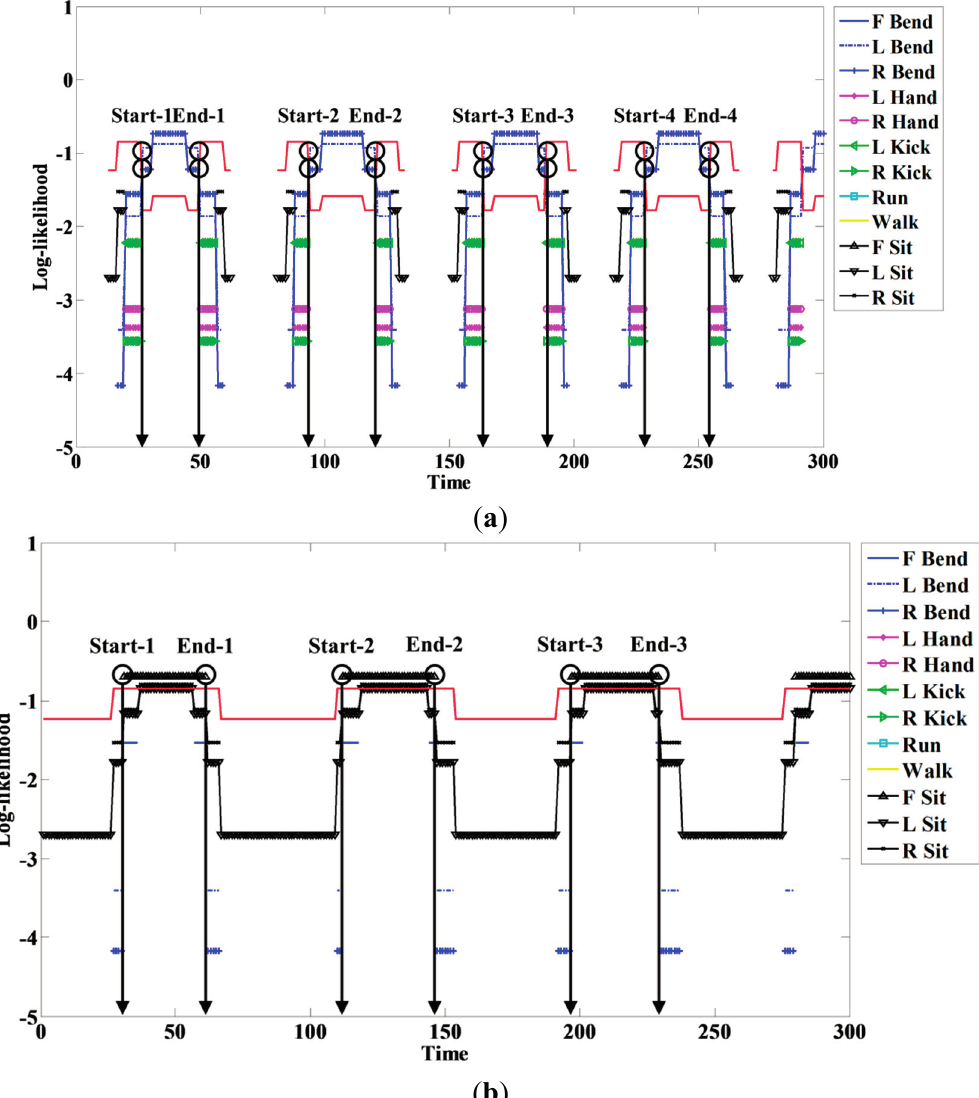
Figure 9. Start and end point detection for ( a ) R Bend; and ( b ) F